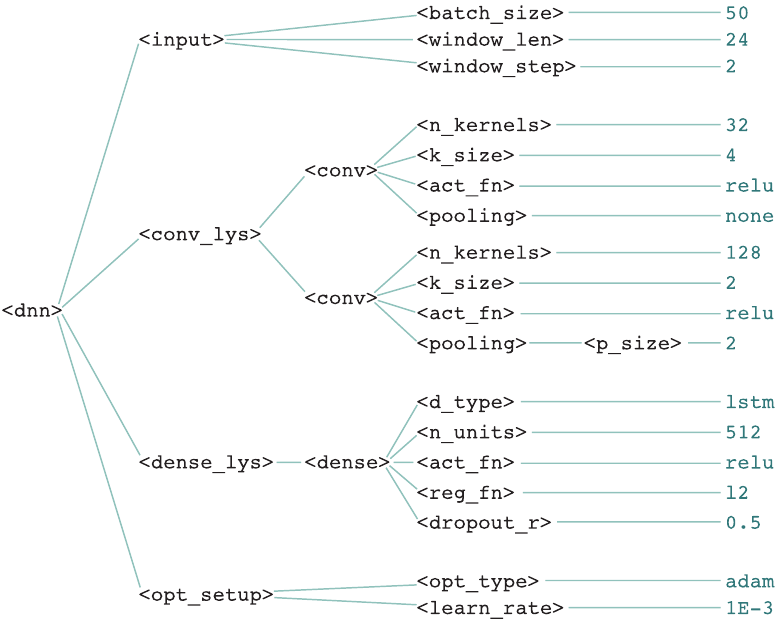
Figure 4. Derivation tree of a sample